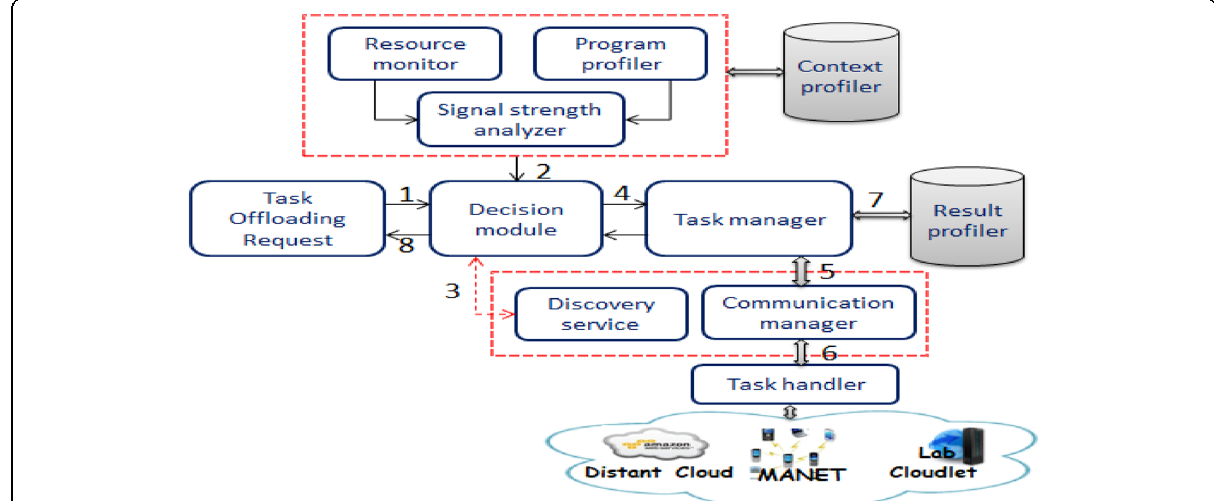
Fig. 7 Task execution flow diagram. Figure 7 shows the task execution flow: 1. Sending task execution request to the decision module. 2. Collecting requested parameters from the resource monitor, program profiler, and signal strength analyzer. 3. Get the required information of